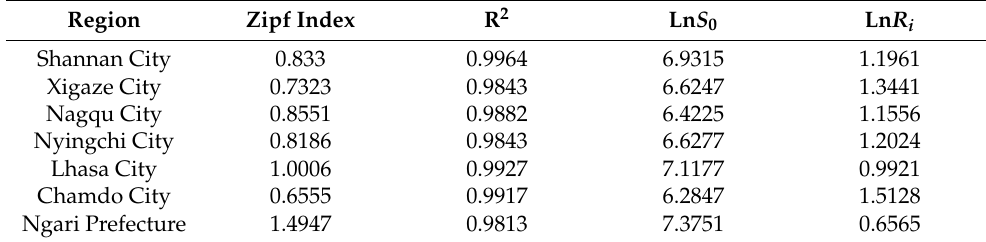
Table 2. Indices related to residential patch size in